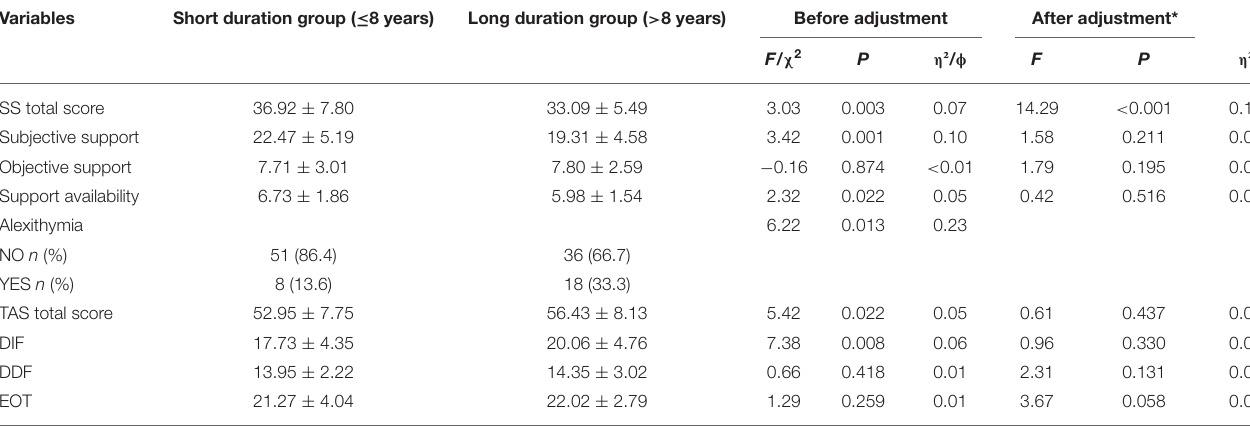
TABLE 2 | Comparison of social support rating scale and twenty–item Toronto alexithymia scale scores between short duration and long duration groups (Mean ± SD).